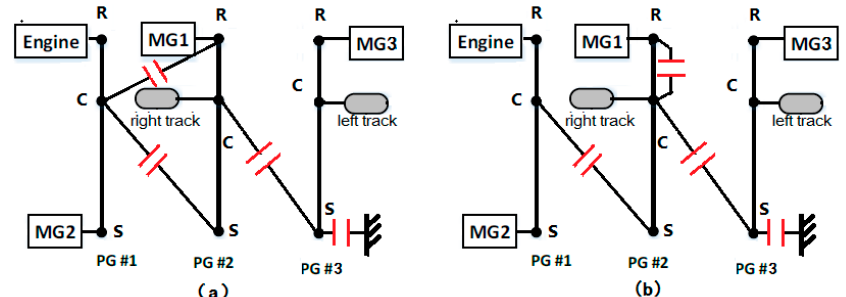
Figure 9. Examples of two designs with identical dynamic characteristics. ( a ) One candidate design; ( b ) another candidate design with different clutch locations.